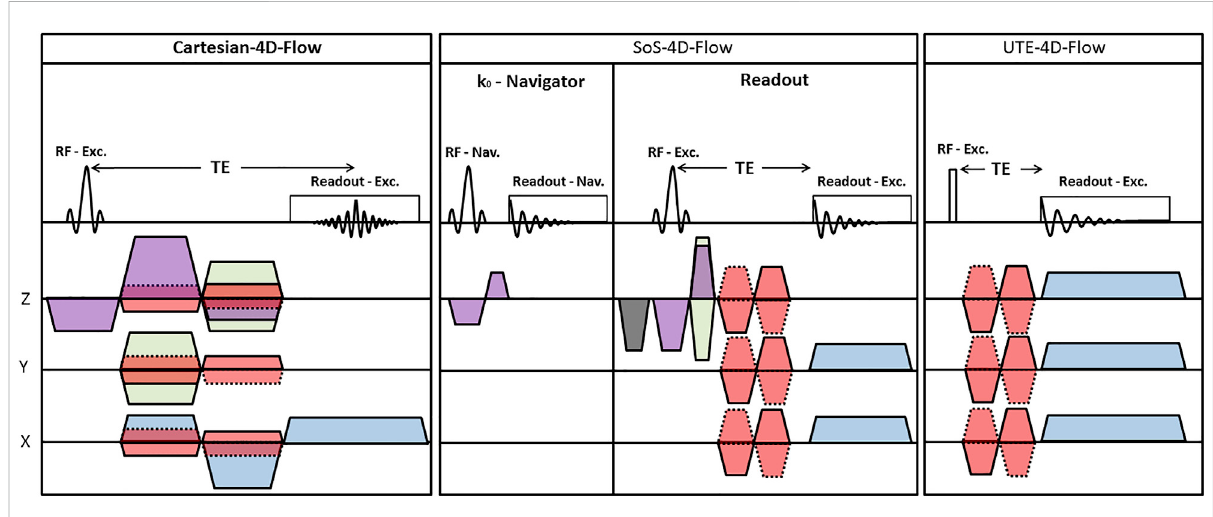
FIGURE 1 Schematic representation of ( left ) the prospectively-triggered Cartesian-4D- fl ow; ( middle ) k 0 -navigated golden-angle center-out SoS-4D- fl ow; and ( right ) UTE-4D- fl ow pulse sequences. (Purple: Slice/Slab-selection gradient; Gray: Slice/Slab spoiler gradient; Green: Phase encoding gradient; Red: velocity encoding gradient; Blue: Readout